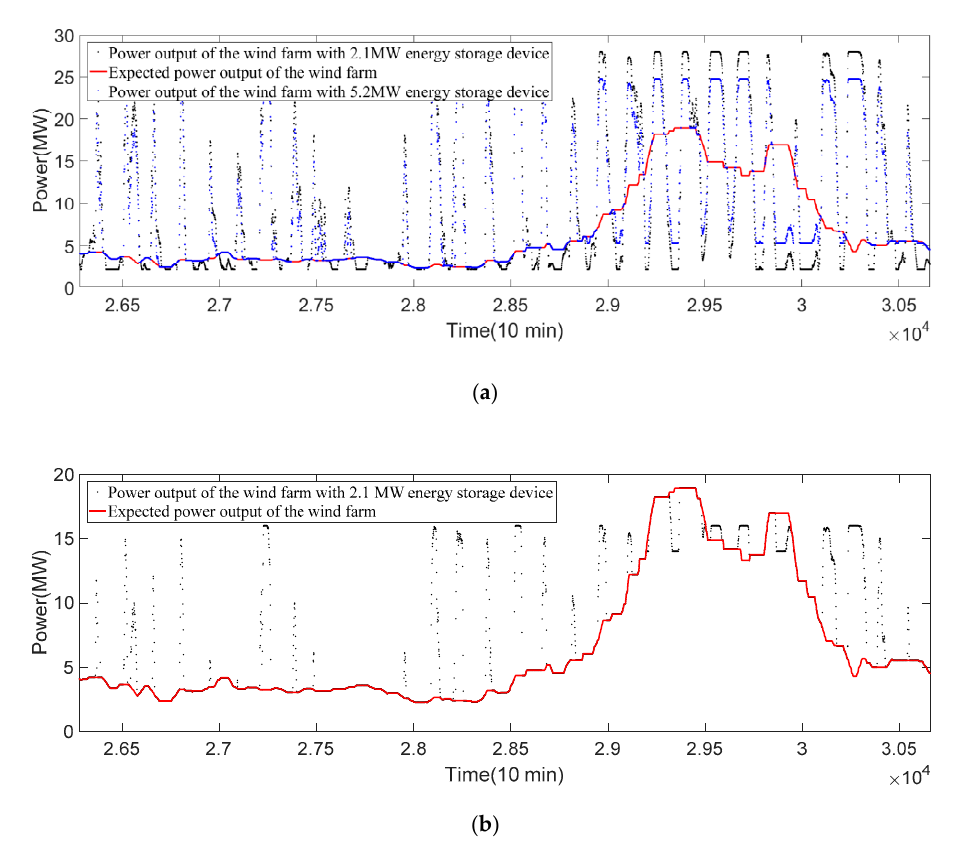
Figure 7. ( a ) The output curves of the simulated wind-storage hybrid power system in June; ( b ) The output curves of the simulated wind-storage hybrid power system in December.